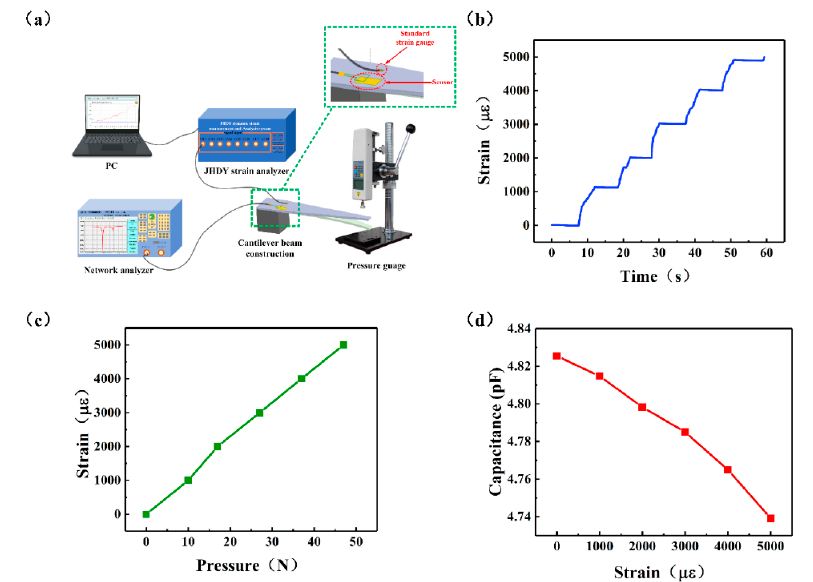
Figure 3. Strain measurement device and results: ( a ) Strain measurement device; ( b ) Experiment data under different pressure; ( c ) Change in strain as a function of pressure, and ( d ) Interdigital capacitance change as a function of